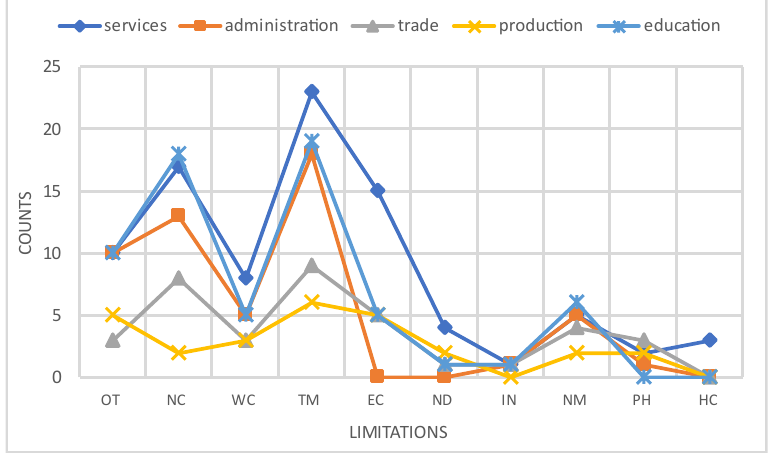
Figure 25. A graph of interactions between the limitations of bus availability and the respondent’s industry.